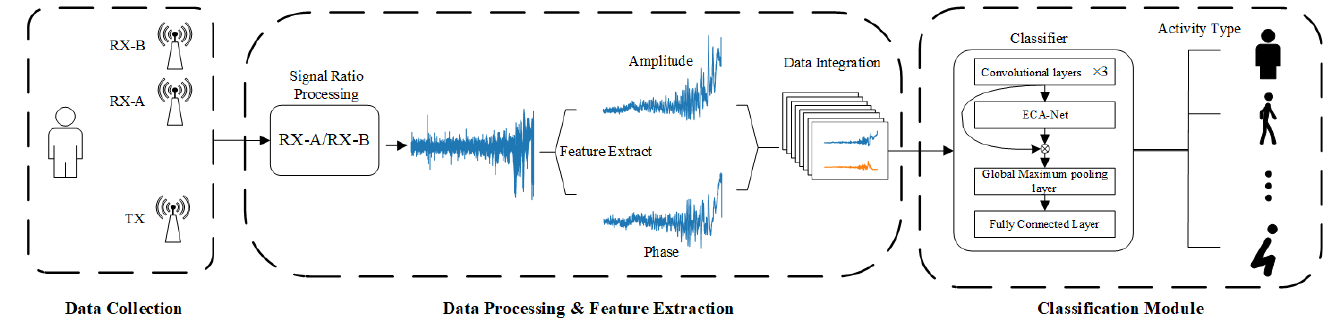
Figure 2. The proposed LoRa and deep learning-based activity recognition framework.